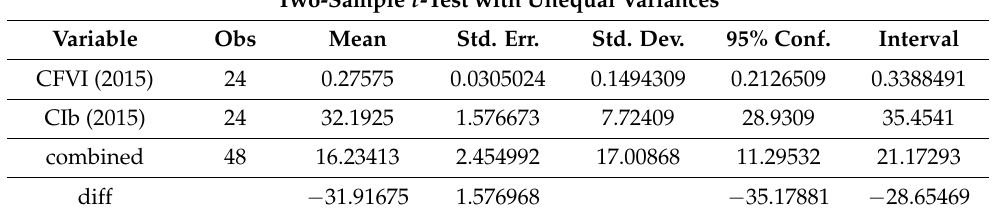
Table 15. Results of Hypothesis